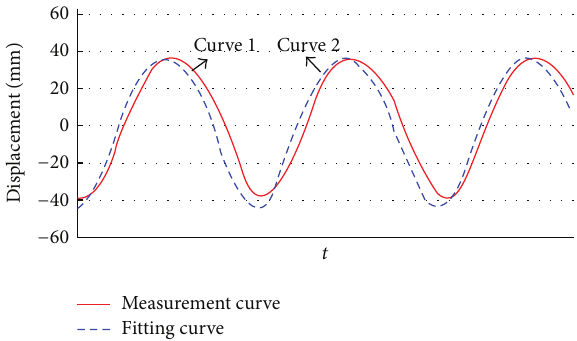
Figure 8: An example of the sampled dynamic data.